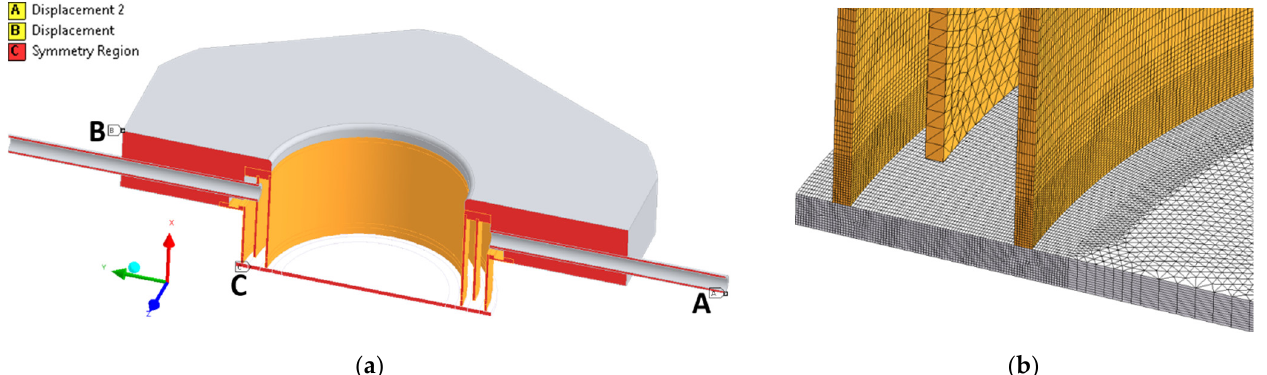
Figure 3. ( a ) Boundary conditions applied in the structural analysis for the reference case; ( b ) details of the mesh generated at the disk interface with inner and outer cuffs.